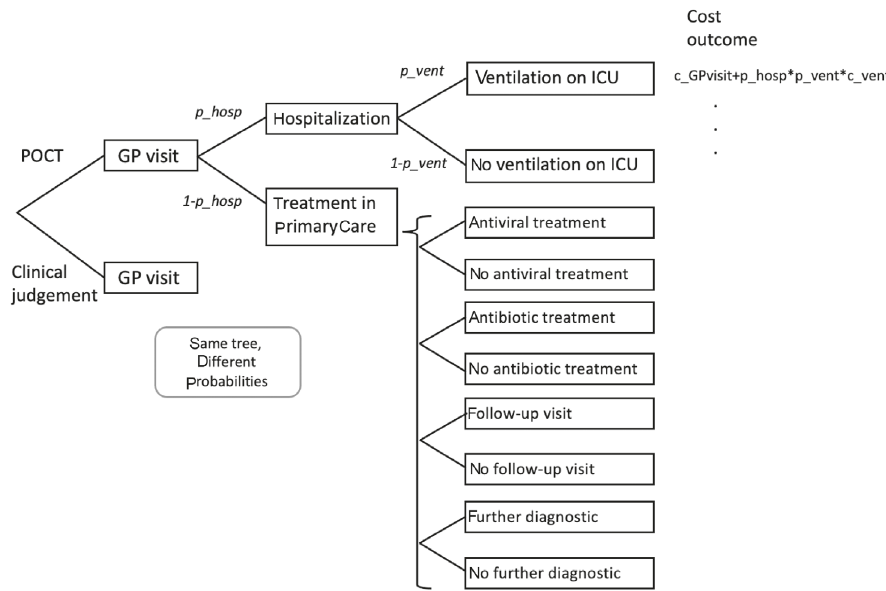
Fig. 1 Simpli fi ed cost-of-illness calculation model. The fi gure shows the decision tree and simpli fi ed cost calculation model that was developed to simulate ILI patients in primary care with the two different diagnostic